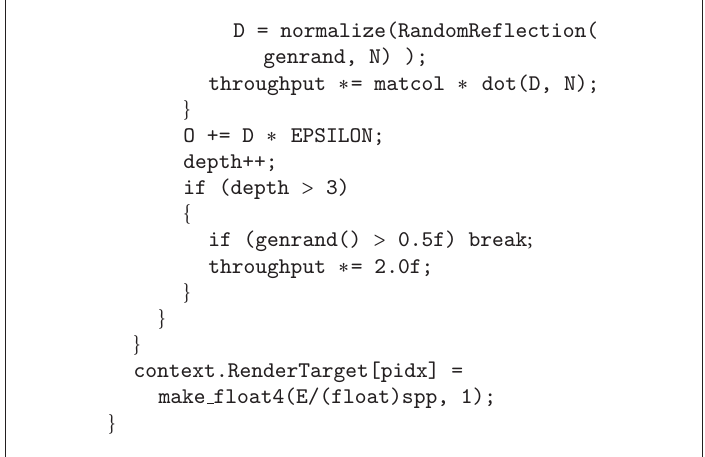
Algorithm 2: Path tracing implemented in